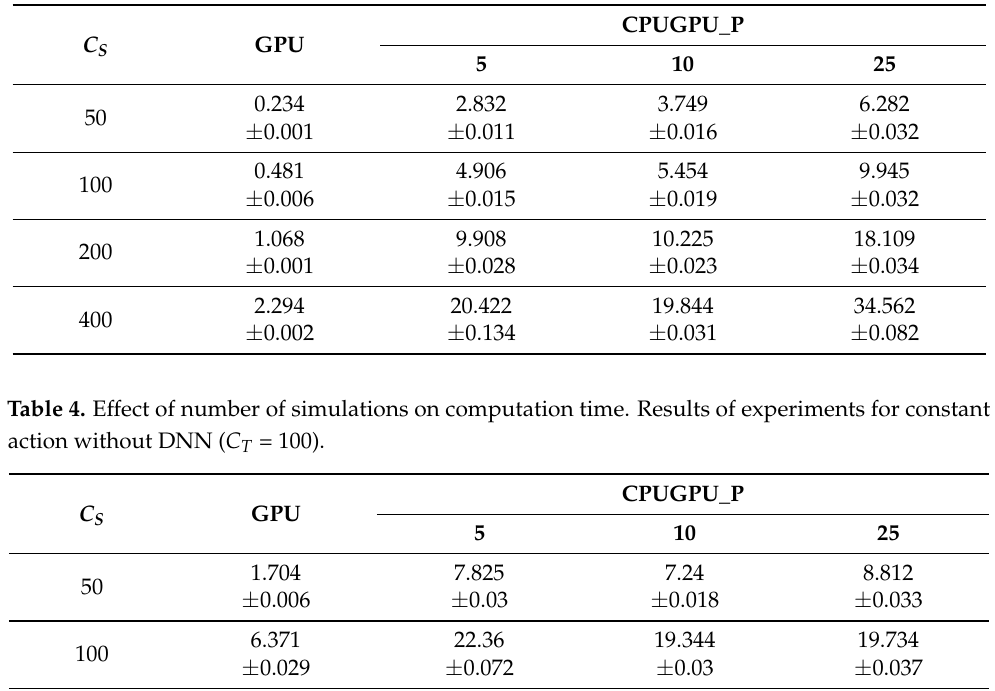
Table 3. Effect of number of simulations on computation time. Results of experiments for random action without DNN ( C T = 100).